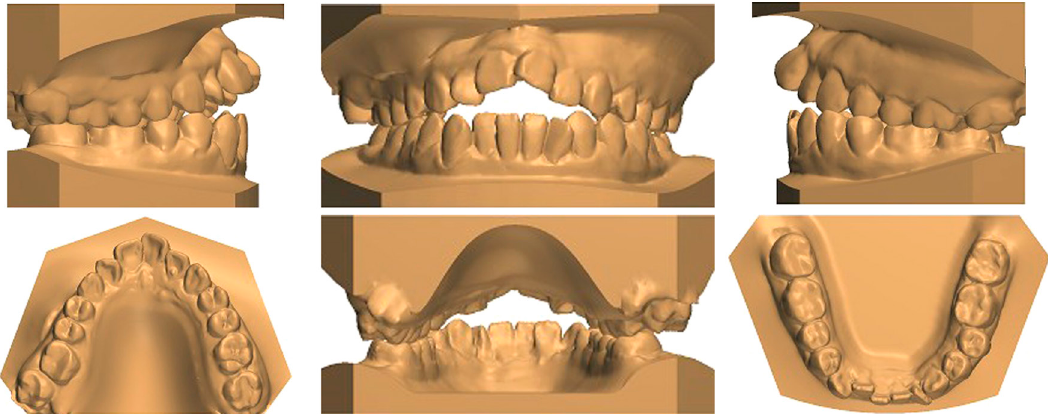
Figure 2. Initial study